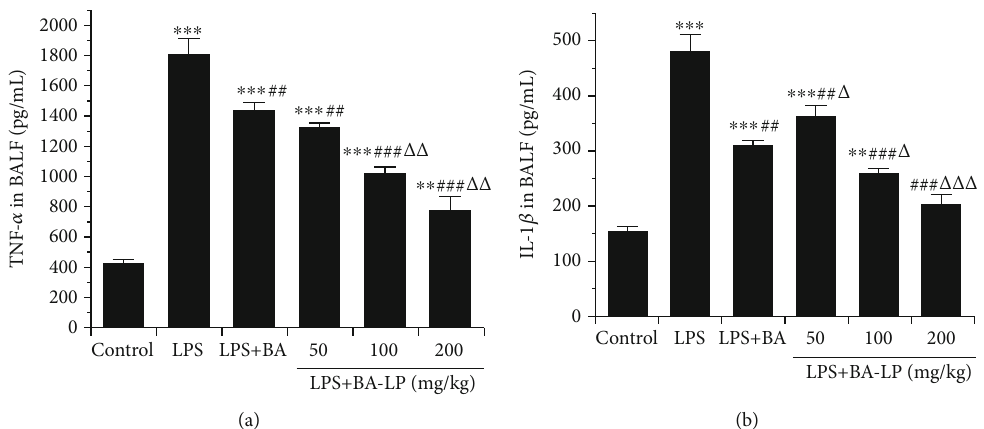
Figure 5: E ff ect of BA on the levels of TNF- α (a) and IL-1 β (b) in BALF. The values were presented as means ± SD ( n = 5 ). ∗∗ P < 0 : 01 and ∗∗∗ P < 0 : 001 vs. the control group; ## P < 0 : 01 and ### P < 0 : 001 , vs. the LPS group; and △ P < 0 : 05 , △△ P < 0 : 01 , and △△△ P < 0 : 001 vs. the LPS +BA group.